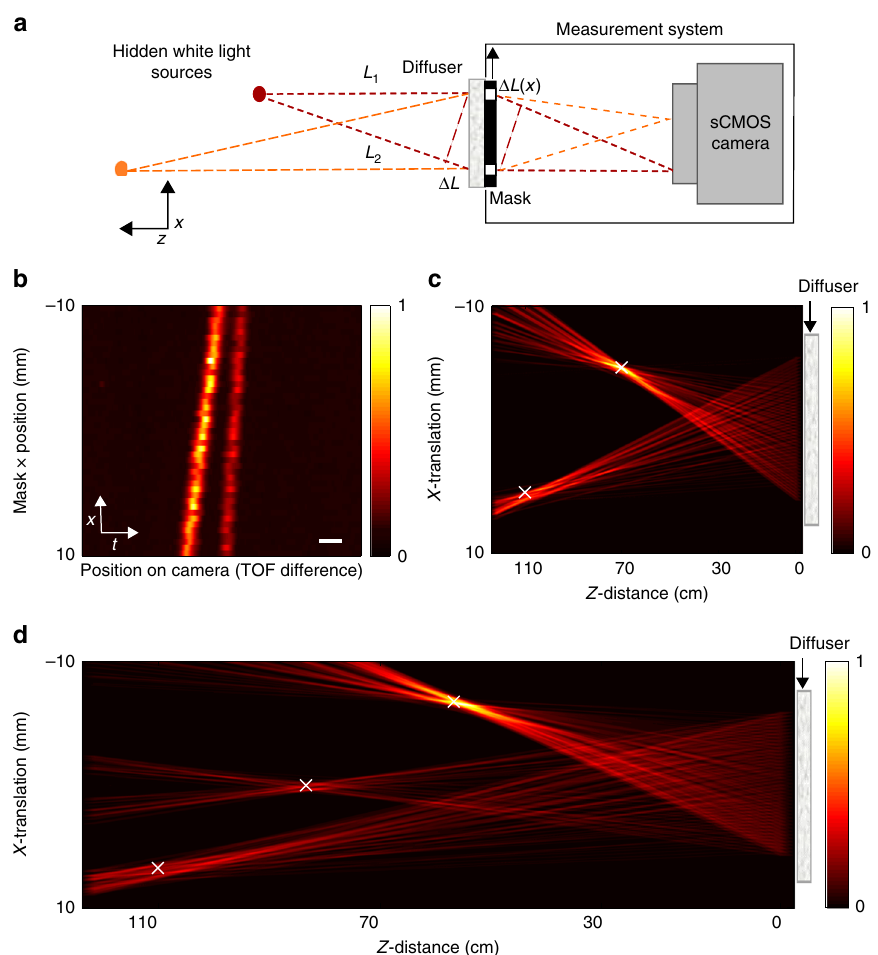
Fig. 3 Experimental localization of multiple hidden sources. a Simpli fi ed sketch of the setup with two hidden sources (white-light LEDs). b Detected envelope of the interference fringes as a function of the mask position (vertical axis). The fringes positions (horizontal axis) mark the TOF differences. c Hidden scene reconstructed from ( b ) by back-projection. Each fringe position in a row in ( b ) localizes the sources to a hyperboloid. The sources real positions are marked by ‘ x ’ . d Back-projection reconstruction of a scene containing three hidden sources. Scale bar: 100